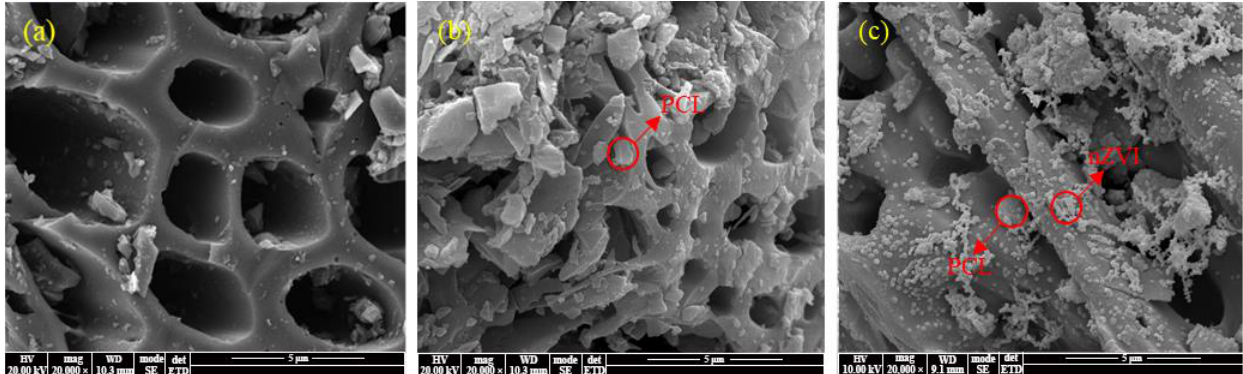
Figure 1. SEM images of BC ( a ), PBC ( b ), and nZVI@PBC ( c ).